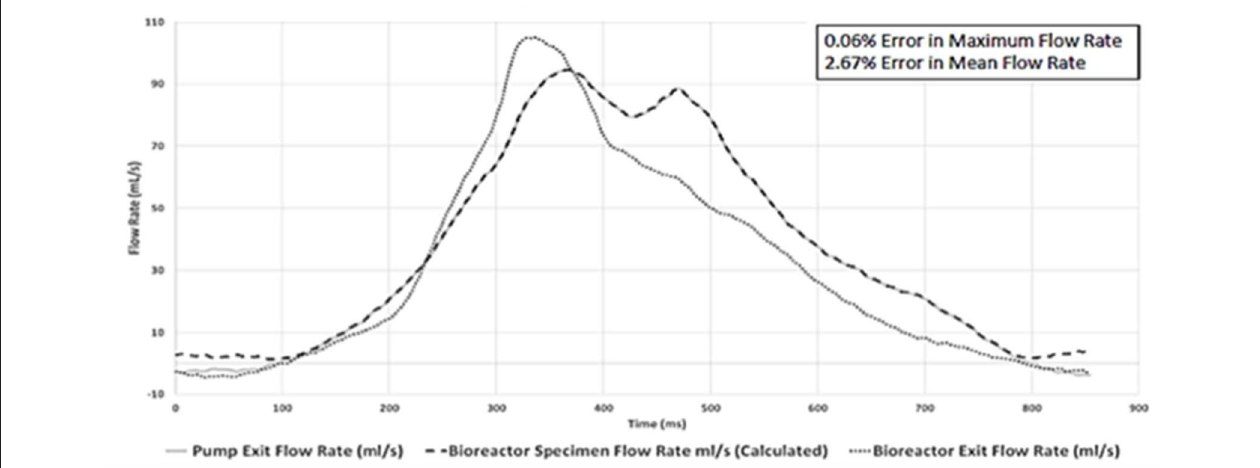
FIGURE 10 | Physiologically-relevant pulsatile flow profile comparison at three flow-loop locations. Close agreements between the pump exit and the bioreactor specimen location flow rates (peak flow error 0.06%; mean flow error 2.67%) were found. This demonstrated that the bioreactor chamber-housed, cell-seeded scaffold specimens would receive the intended aortic pulsatile flow waveform utilized in the tissue engineering